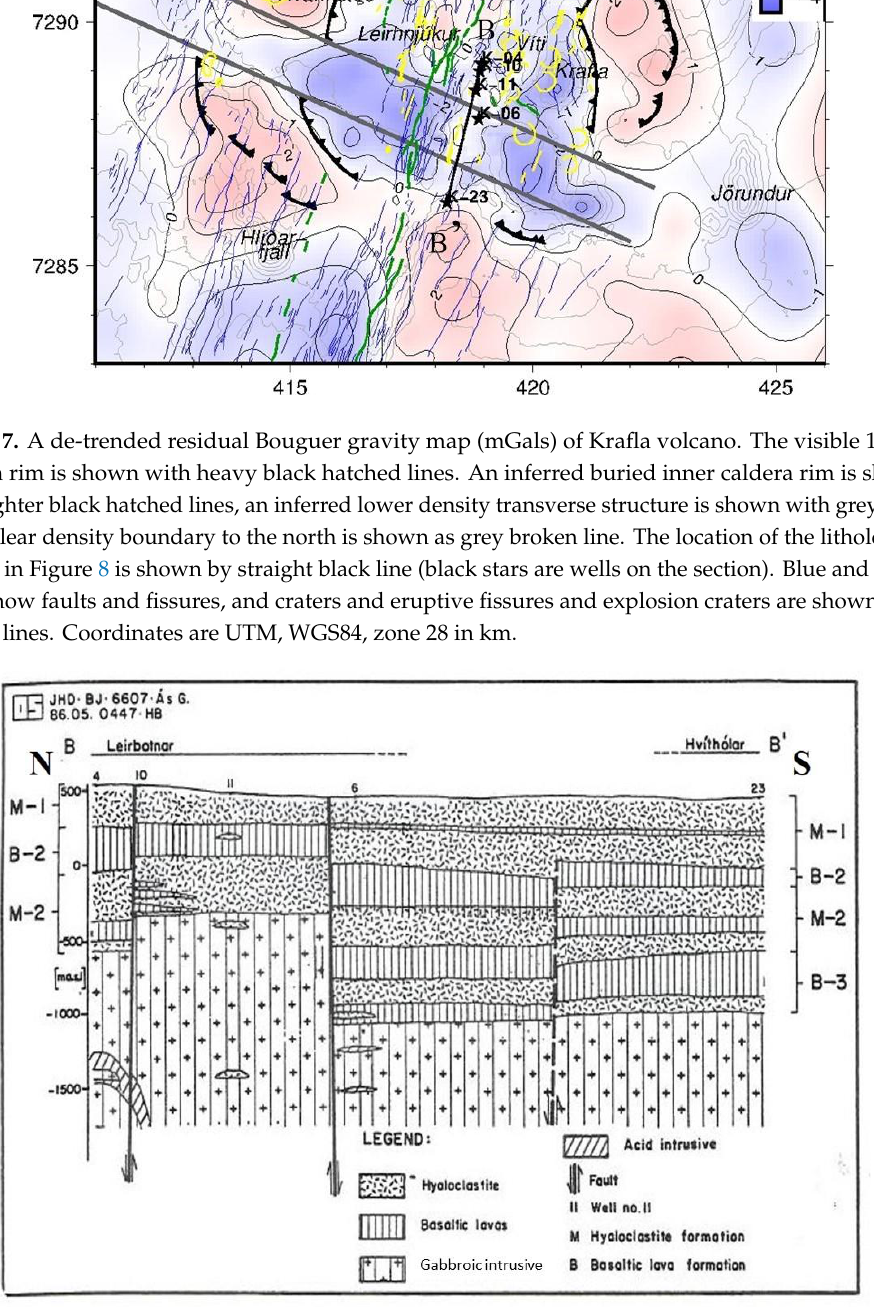
Figure 8. A lithological cross-section based on drilled wells on a N–S trending profile in Krafla [11]. The location of the profile is shown in Figure 7.